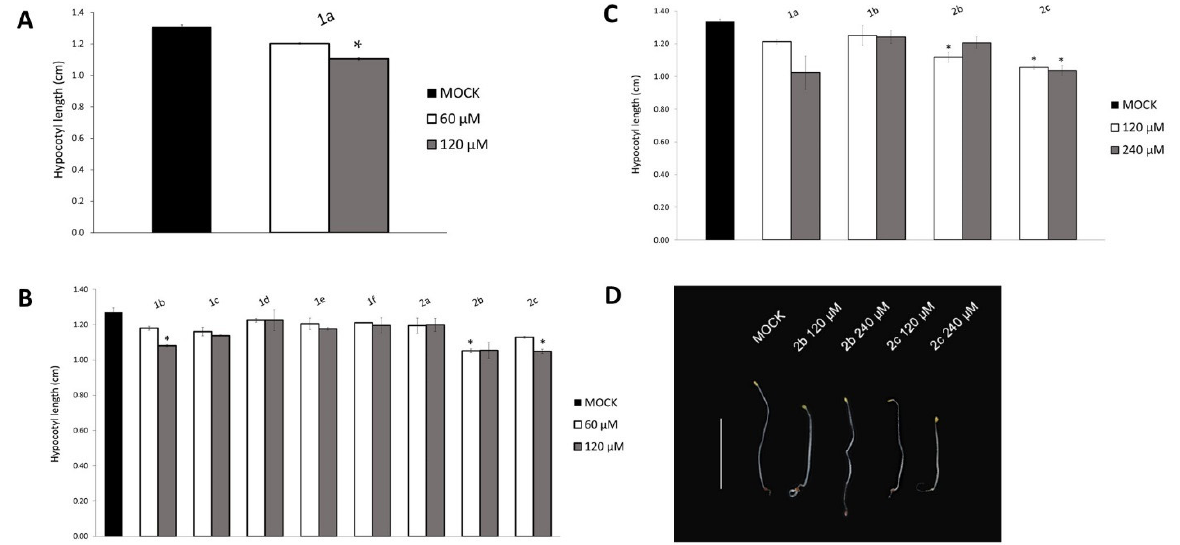
Figure 4. Selection of active compounds through a phenotypic screening. The hypocotyl length of wild type 6-day-old seedlings was treated with: ( A ) 1a (60, 120 µ M), ( B ) 1b – f and 2a – c (60, 120 µ M), ( C ) with the selected compounds 1b , 2b , and 2c compared to 1a (120 and 240 µ M). All the samples were compared to the DMSO-treated control (MOCK). ( D ) Six-day-old seedlings treated with DMSO (MOCK) or with compounds 2b and 2c (120 and 240 µ M). Scale bar, 1 cm. The values of the hypocotyl length are the mean of two biological replicates (50 seedling each) presented with SD values. Significant differences from the mock were analyzed by t -test (* p ≤ 0.01).